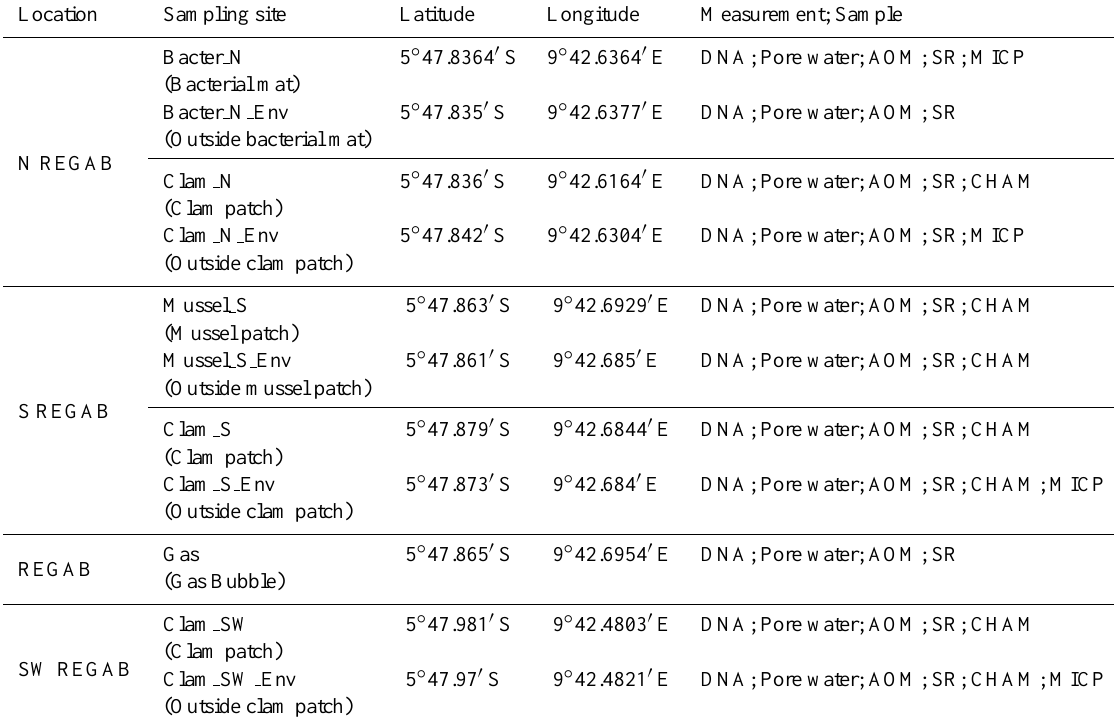
Table 1. Overview of the sampling sites, their geographic position and type of measurements performed within this study. Sampling and mea- surements were conducted in July–August 2008. AOM = Anaerobic Oxidation of Methane, SR = Sulphate Reduction, MICP = microprofiler measurement, CHAM = Benthic Chamber